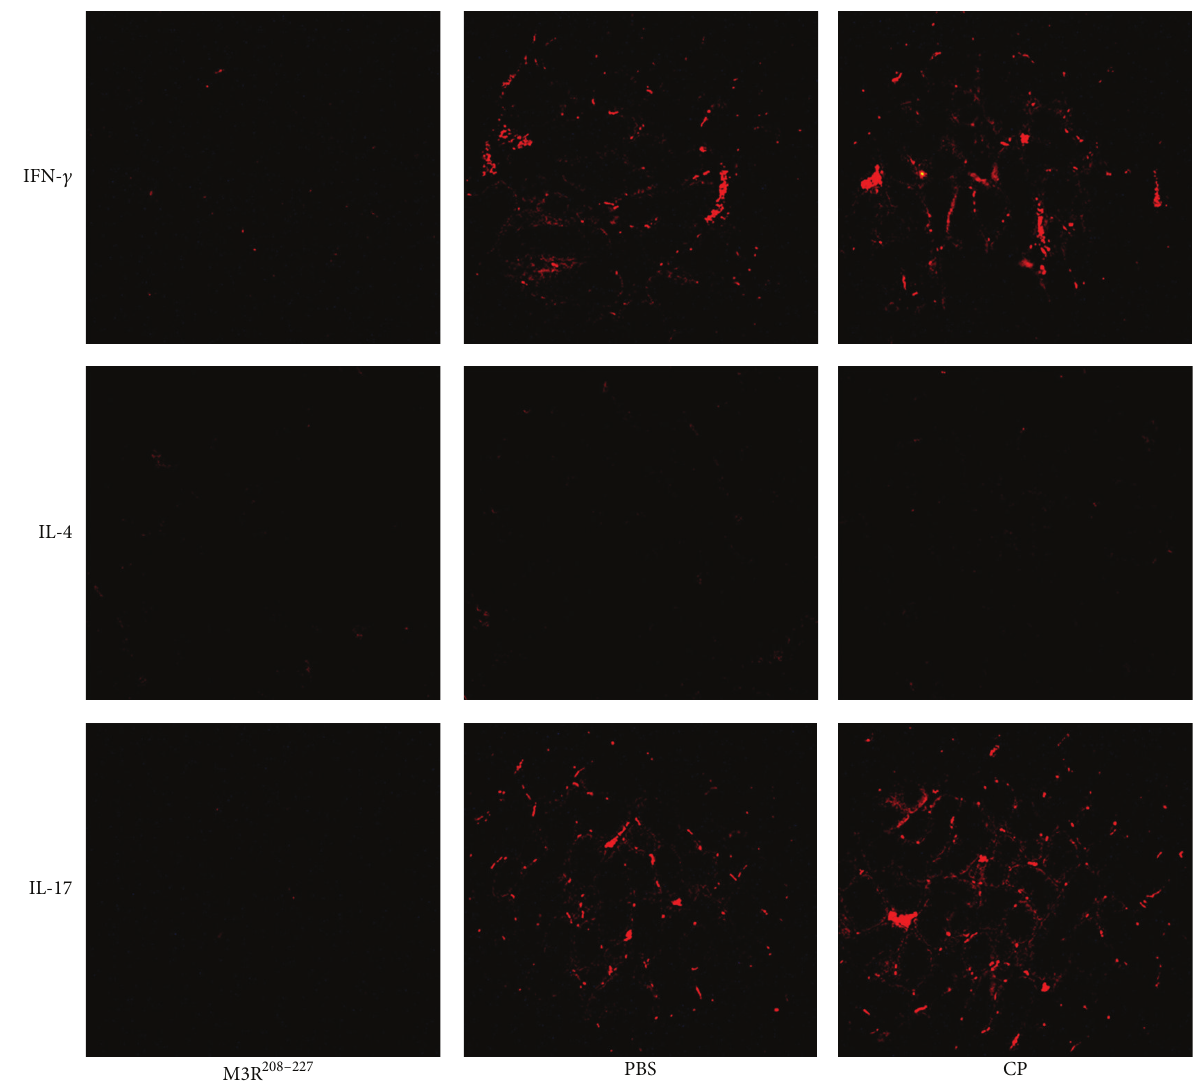
Figure 4: Reductions in the levels of IL-17 and IFN- 𝛾 in the lacrimal glands following immunization with the M3R 208−227 peptide. To further observe whether the concentrations of cytokines decreased in the lacrimal glands, we also examined the production of IFN- 𝛾 , IL-4, and IL-17 in the lacrimal glands of NOD/LtJ mice by immunofluorescence staining. Whole lacrimal glands from NOD/LtJ mice were removed, fixed, embedded, and incubated with primary antibodies, followed by a secondary goat anti-rat IgG antibody. The results of immunofluorescence staining demonstrated that the production of IL-17 and IFN- 𝛾 decreased in the lacrimal glands of NOD/LtJ mice immunized with the M3R 208−227 peptide. In contrast, the production of IL-4 was not observed in the lacrimal glands of NOD/LtJ mice in all